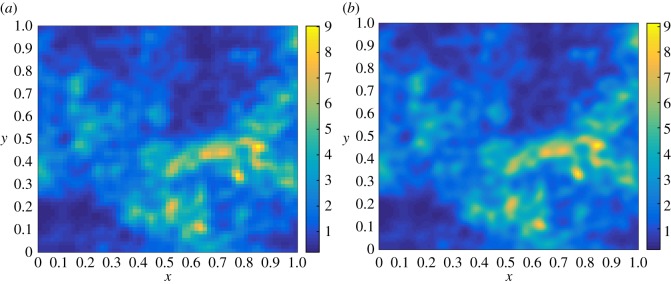
Two samples of the same random permeability field in two consecutive levels ℓ (a) and ℓ+1 (b) to be used as input in the MLMC method. In this example, we used ℓ=3.